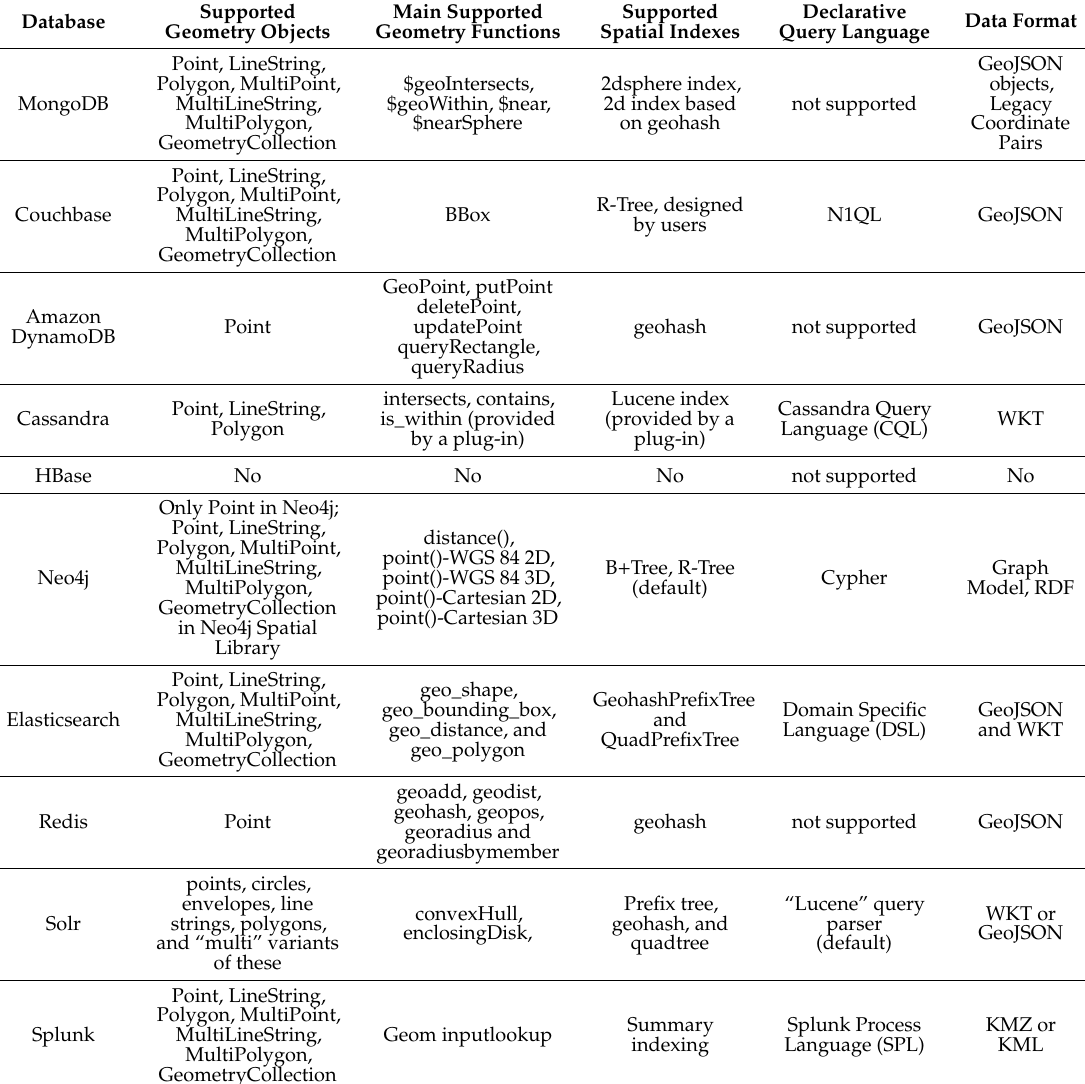
Table 4. A Comparison of NoSQL databases in terms of their geospatial features. WKT, Well-known Text; KMZ, Keyhole Markup Zipped; KML, Keyhole Markup